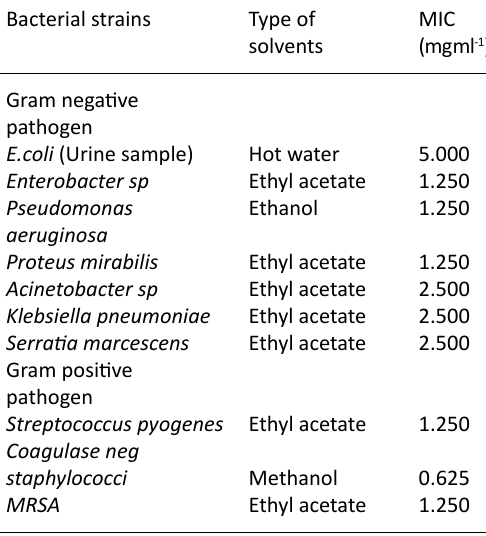
table 3. Minimum inhibitory concentration (MIC) of the different solvent extracts of G. boninense fruiting bodies against selected bacterial strains Bacterial strains